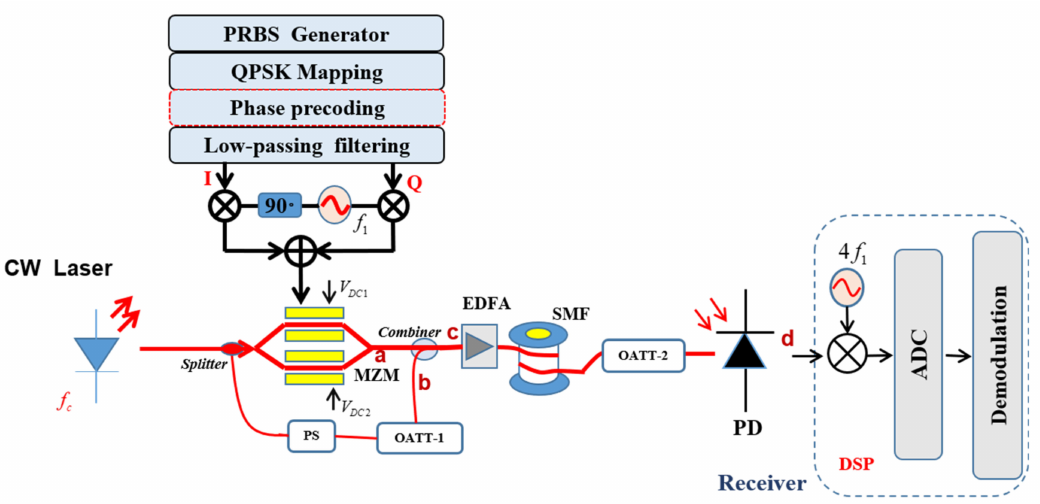
Figure 1. Principle of photonic filter-less scheme for generating frequency quadrupling vector mm- wave signal. CW Laser, continuous wave laser; MZM, Mach-Zehnder modulator; PS, Phase shifter; OATT, Optical attenuator; EDFA, Erbium doped fiber amplifier; DSP, Digital signal processing; ADC, Analog to digital conversion; SMF, Single-mode fiber; PD,